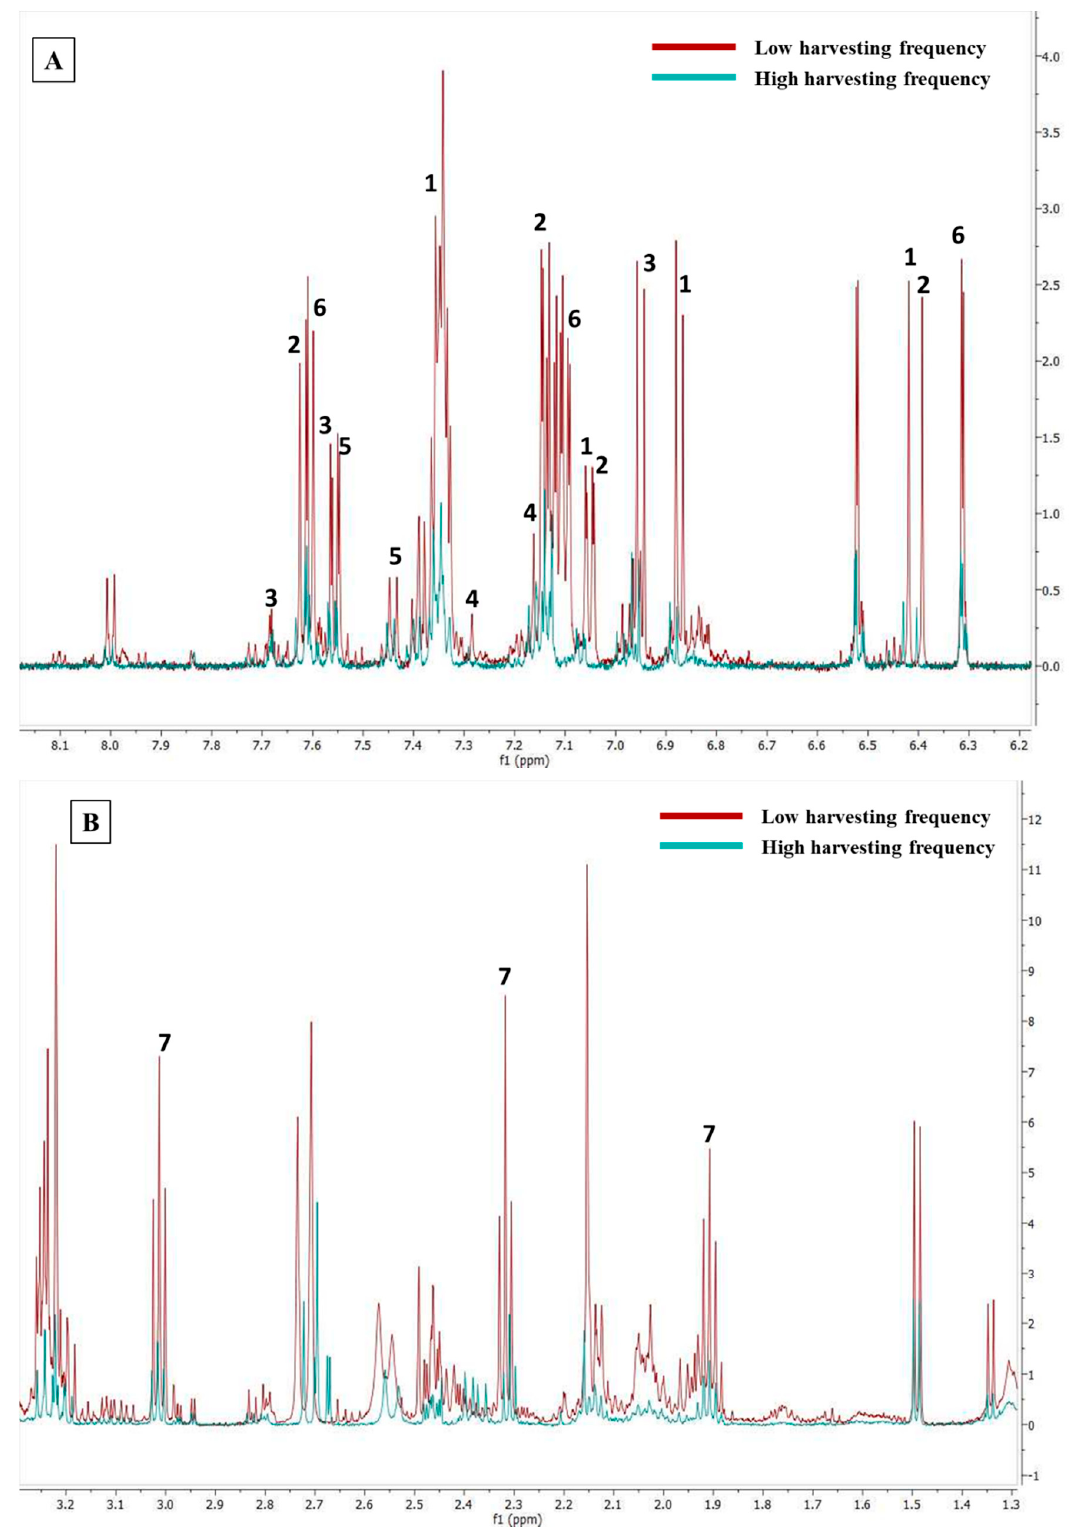
Figure 7. NMR aromatic ( A ) and aliphatic ( B ) region showing difference between high (blue line) and low harvesting (red line) frequency. 1 = Ferulic acid (6.38, 6.86, 7.05, 7.33 ppm); 2 = Chlorogenic acid (6.39, 7.05, 7.15, 7.64 ppm); 3 = Vanillic acid (6.94, 7.55, 7.65 ppm); 4 = Niarizin (7.16, 7.26 ppm); 5 = Esculetin (7.42, 7.55 ppm); 6 = Wogonin (6.32, 7.09, 7.59 ppm); 7 = Gamma-aminobutyric acid (GABA) (1.9, 2.3, 3.0 ppm). Compounds measured in deuterium oxide:deuterated methanol (CD 3 OD) (1:1).